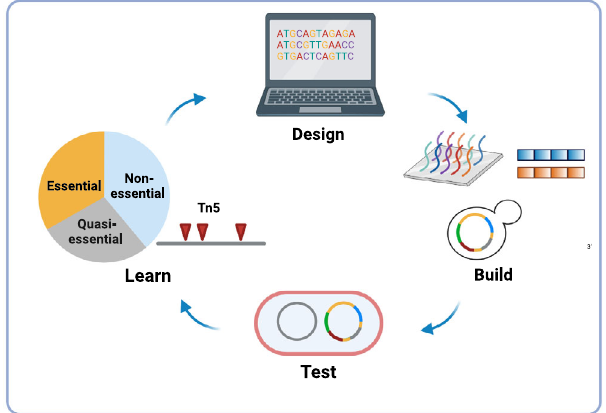
Fig. 3 | ‘ Bottom up ’ construction of a minimal Mycoplasma mycoides genome (JCVI-syn3.0). The minimal genome was fi rst designed based on existing genomic knowledge; the synthesis started from oligonucleotides and gradually assembled into a genome via methods such as polymerase cycling assembly (PCA) and transformation-associated recombination (TAR) in yeast; the genome was extrac- ted from yeast and transplanted into a M. capricolum recipient cell to test its growth. At the end of each cycle, gene essentiality in the resulting strain was re- evaluated by Tn5 mutagenesis. In total, four Design-Build-Test-Learn cycles were conducted to produce a viable strain with its genome smaller than any autono- mously replicating cell in nature